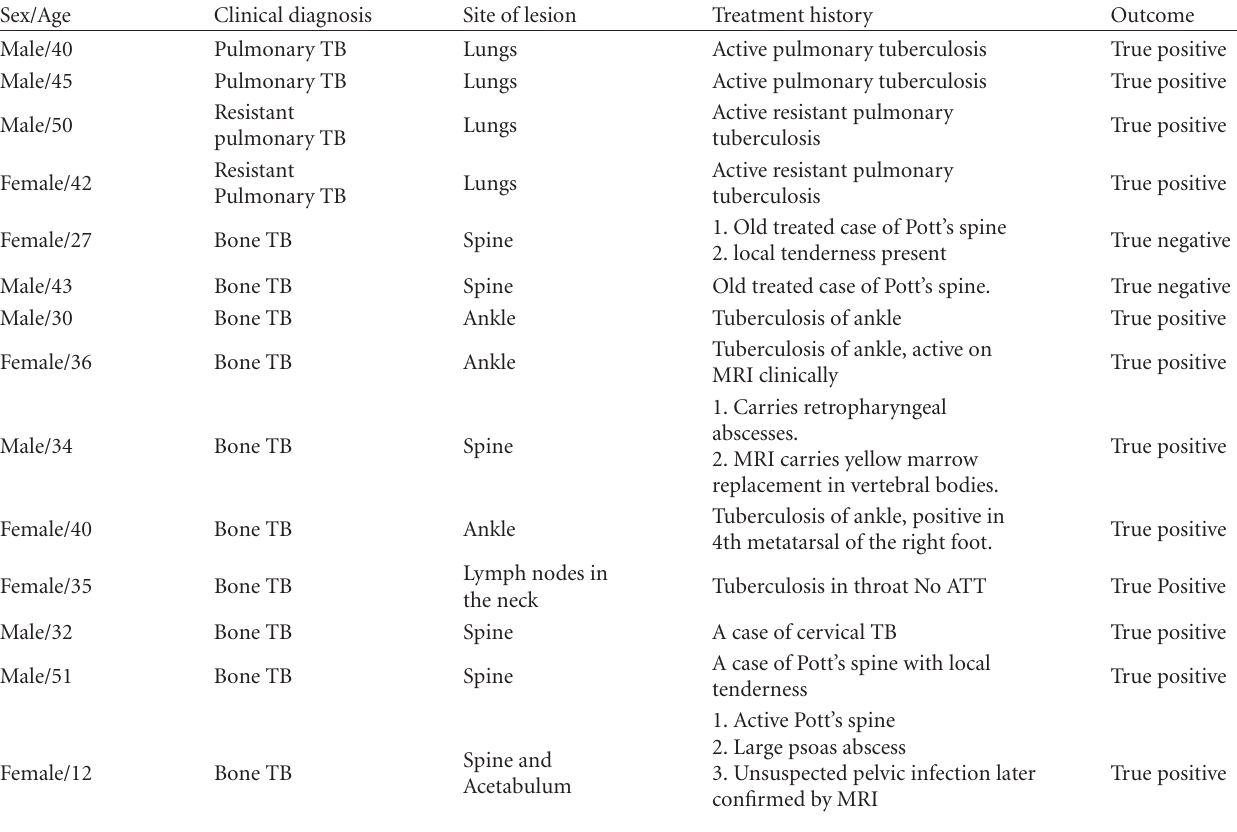
Table 1: Clinical details of patients and result of 99m Tc-EMB scintigraphy.